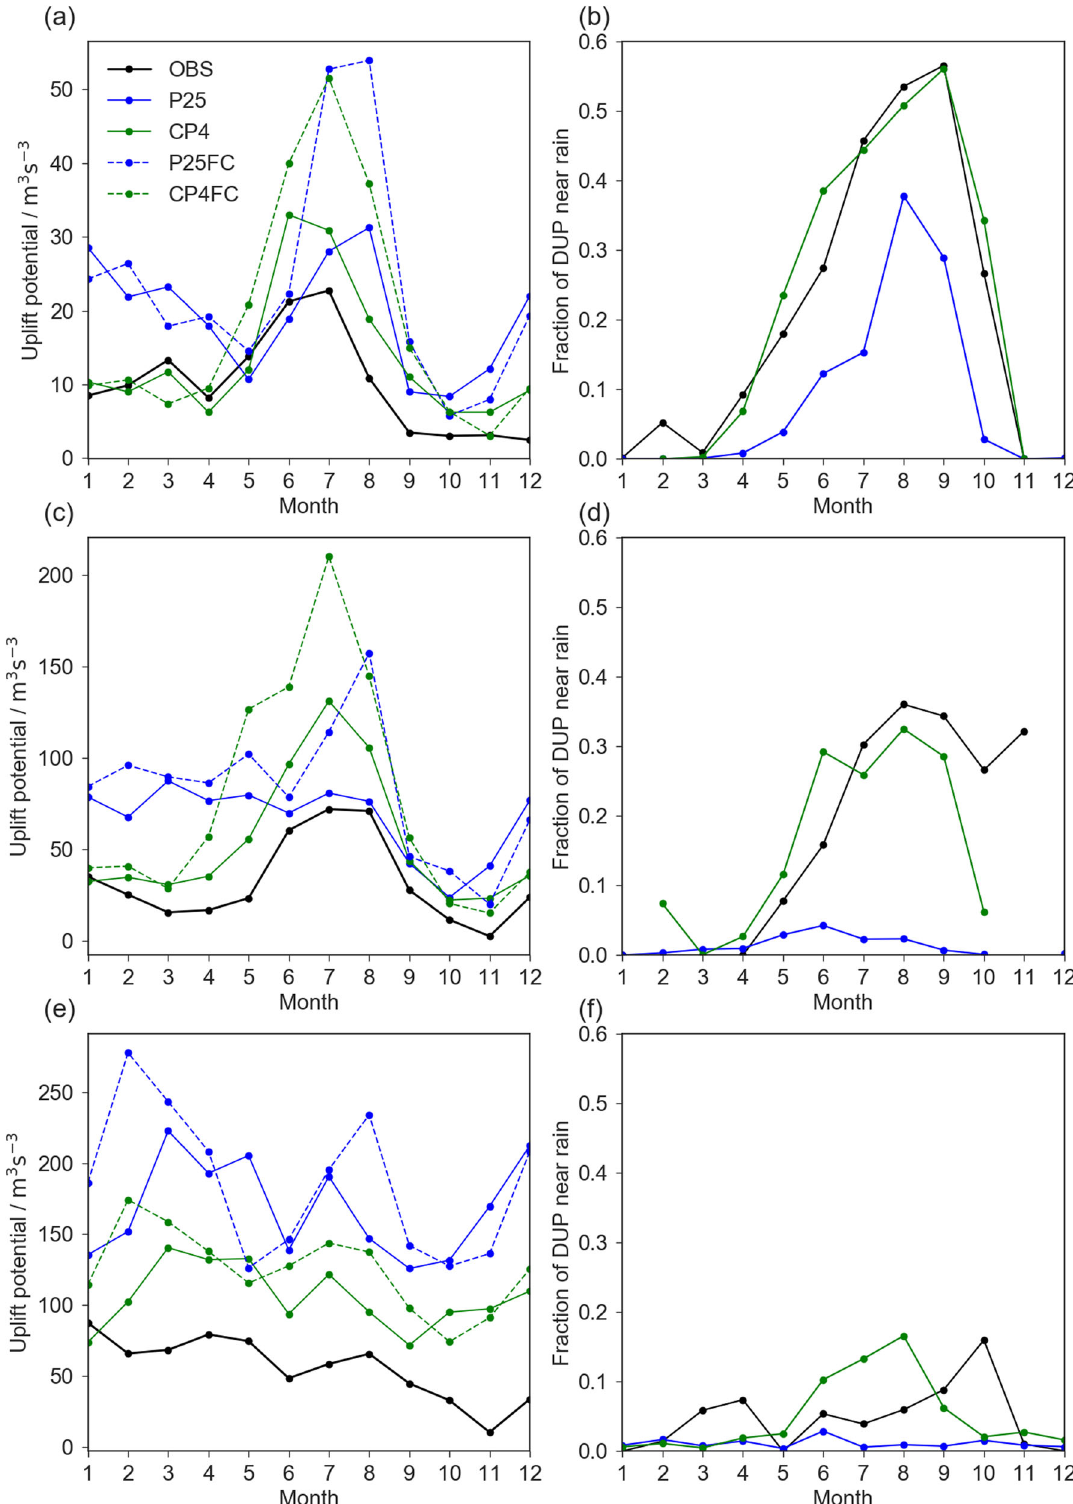
Fig. 1 Seasonal cycle of dust uplift potential (DUP). Total DUP at a Sahel stations, c South Sahara and e Saharan stations (plusses, circle and crosses in Fig. 2a, respectively) and fraction of the total monthly DUP that occurs near rainfall at b Sahel stations, d South Sahara and f Saharan